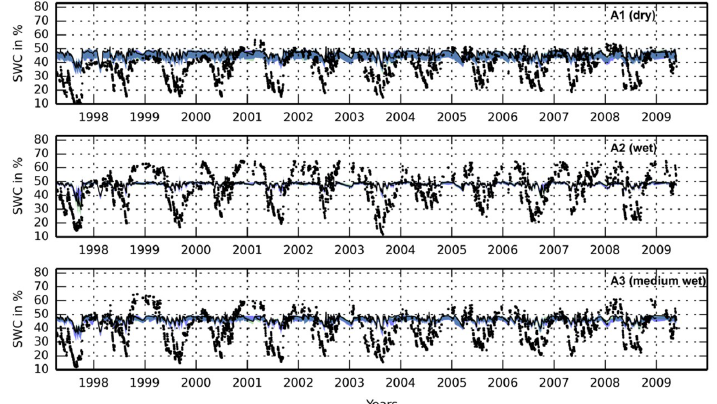
Figure 7. Measured data (black dots) and simulated confidence intervals for the soil water content at 0–15cm for the plots A1, A2 and A3 (from top). Confidence intervals for noGW simulations are shaded in light blue, withGW simulations are in light green and overlap between noGW and withGW in darker blue­green. Black lines depict the median for withGW (solid line) and noGW (dashed line) simulations. Additional information can be found in Tables A3 and A4.